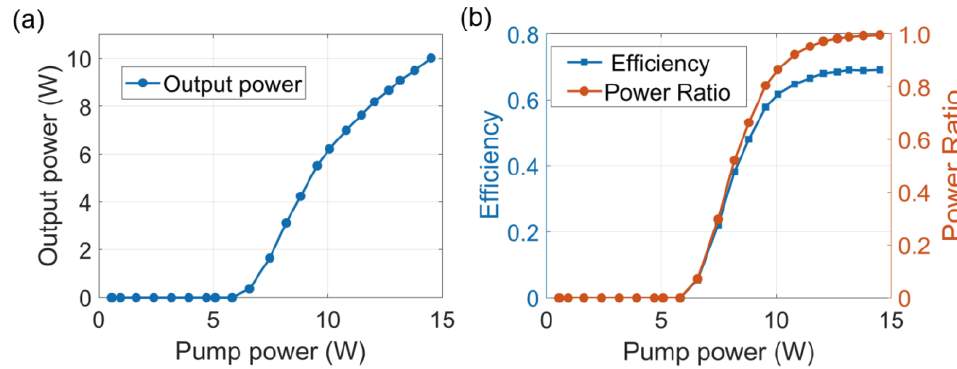
Figure 4. ( a ) The 1694 nm RFL output power versus 1565 nm pump power; ( b ) optical efficiency and power ratio versus 1565 nm pump power.